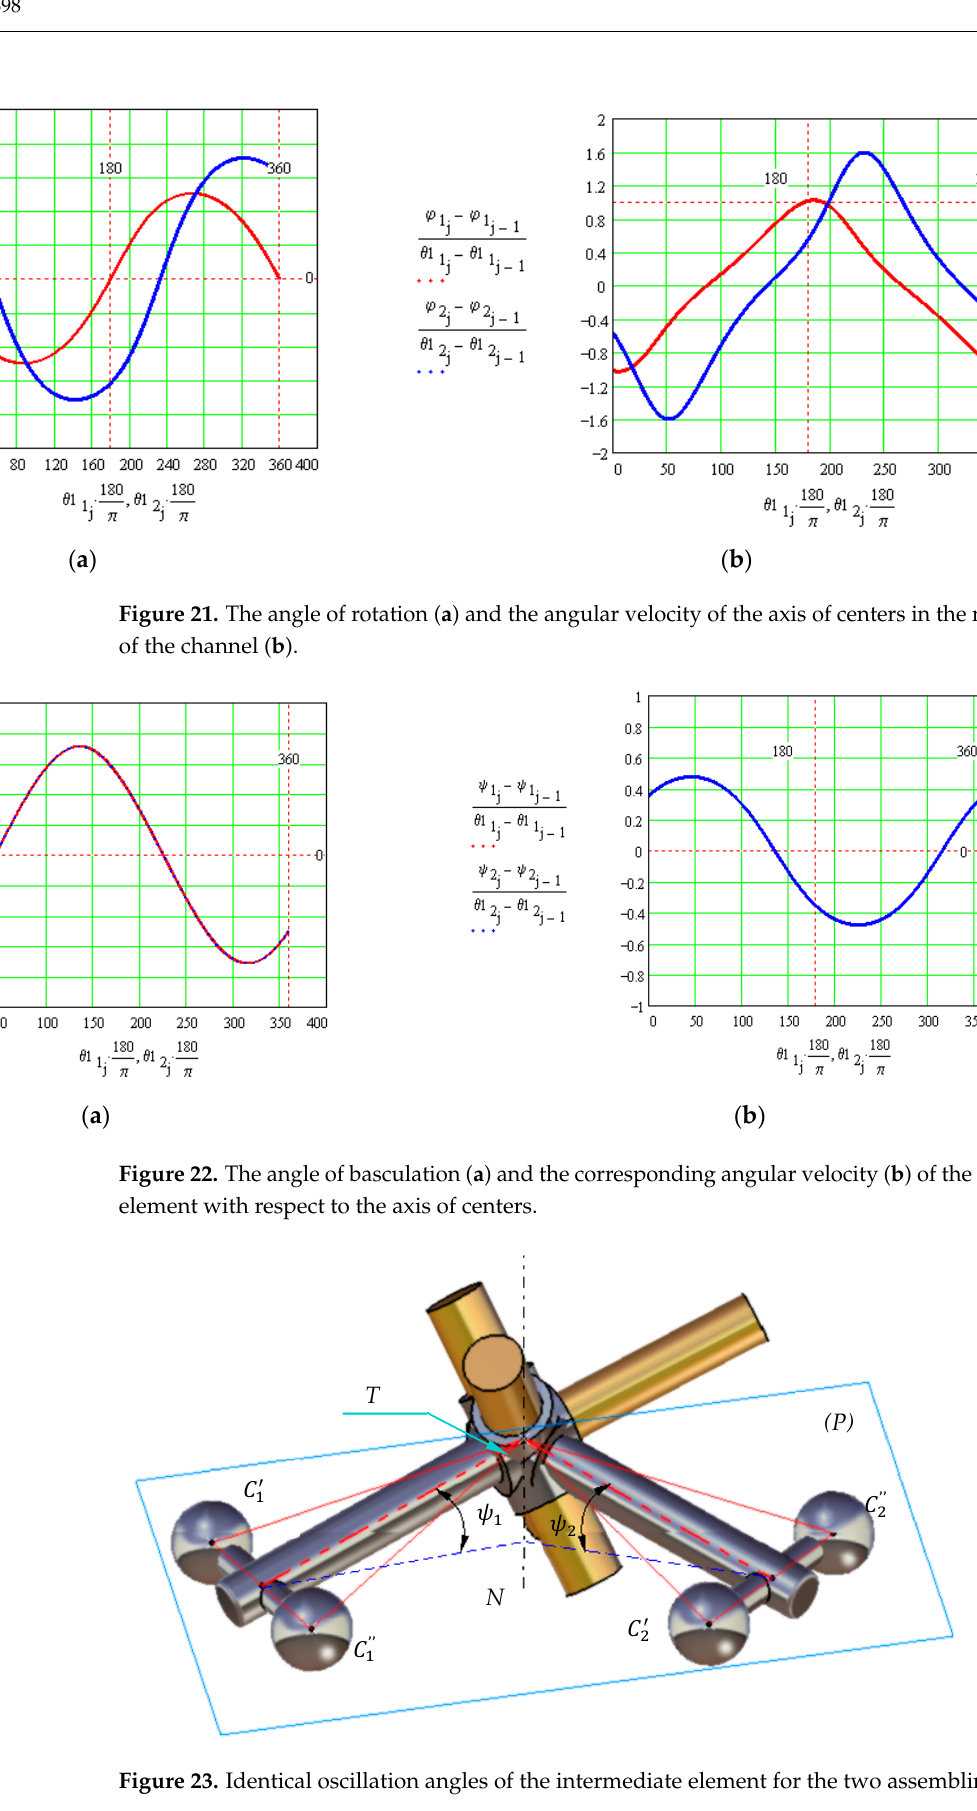
Figure 24. Kinematics simulation of the paths of the centers of the balls in the median plane of the channel for the two assembling solutions.